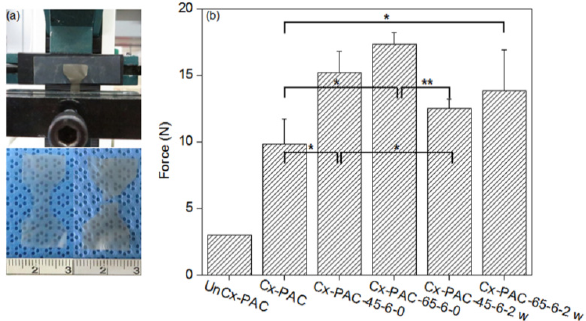
Figure 4. ( a ) Pictures of universal testing machine and film and ( b ) tensile strength of UnCx ‐ PAC and Cx ‐ PAC films aged for zero and two weeks at room temperature after thermal treatment at 45 °C and 65 °C (* p < 0.05, ** p < 0.001).